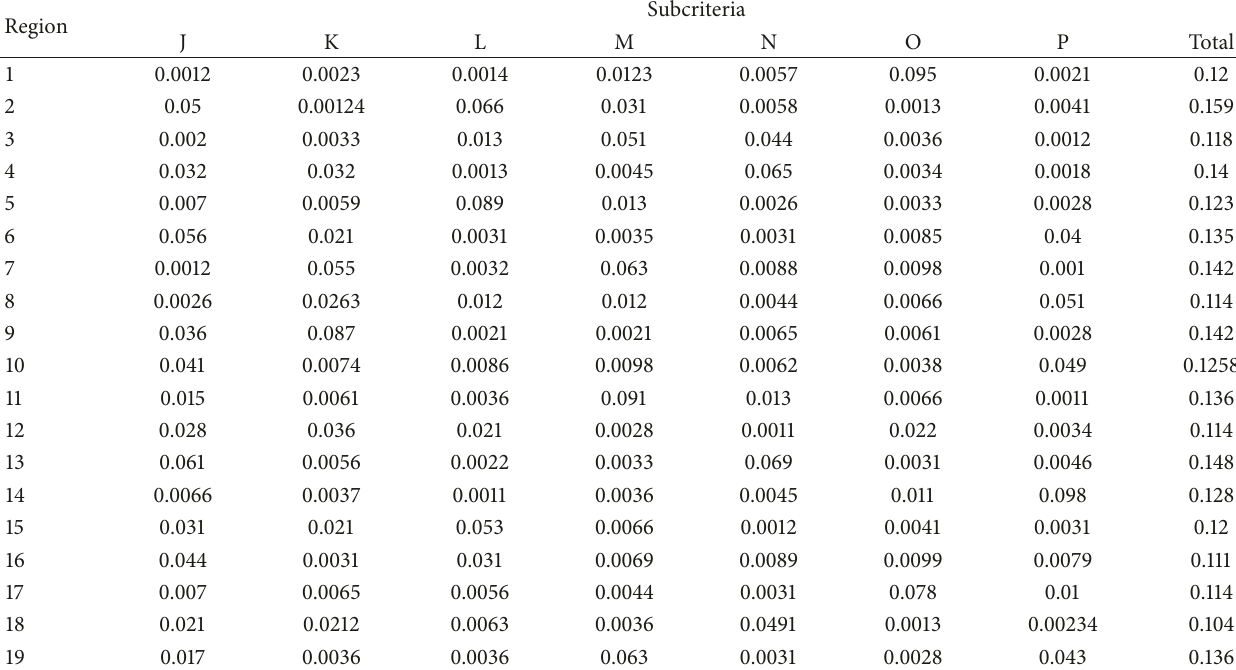
Table 14: Overall priority of each of 19 districts of Qazvin city for the texture responsiveness criteria after the crisis and relief possibility.